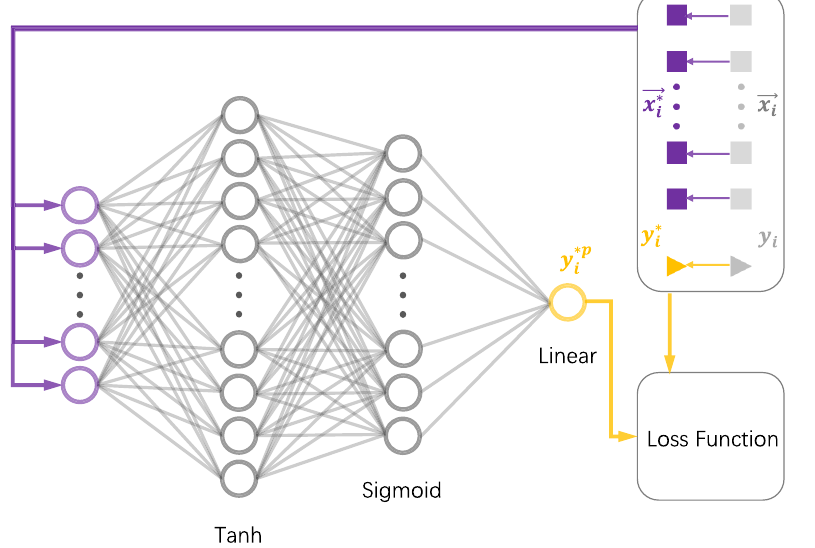
Figure 1. Schematic diagram of our neural network model. We preprocess each training input x i and its corresponding label y i to obtain x ∗ i and y ∗ i . The neural network receives x ∗ i and outputs the corresponding y ∗ The numbers of neurons in the first hidden layer and the second hidden layer of the neural network are 400 p y ∗ and 200, respectively. y ∗ i and i are used to compute the loss function designed by us. Minimization of the loss function completes the training